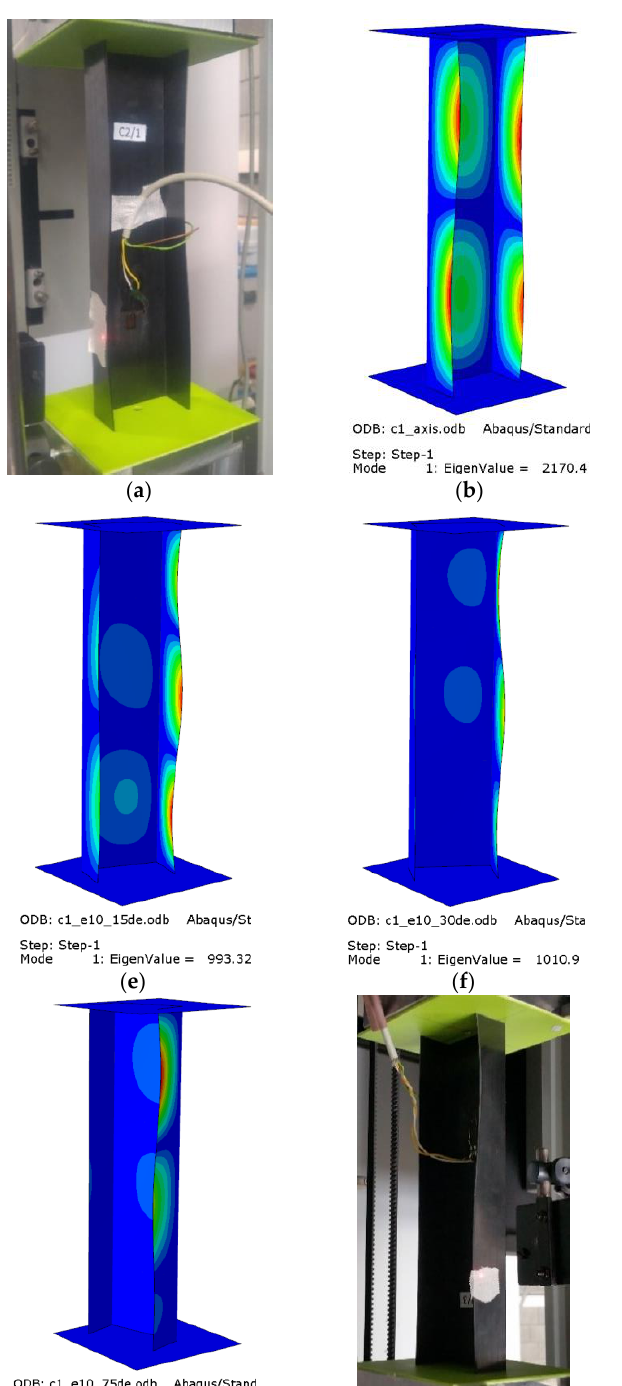
obtained for C1 [0/45/ − 45/90/90/ − 45/45/0] T , while Figure 9 shows the experimental and nu-